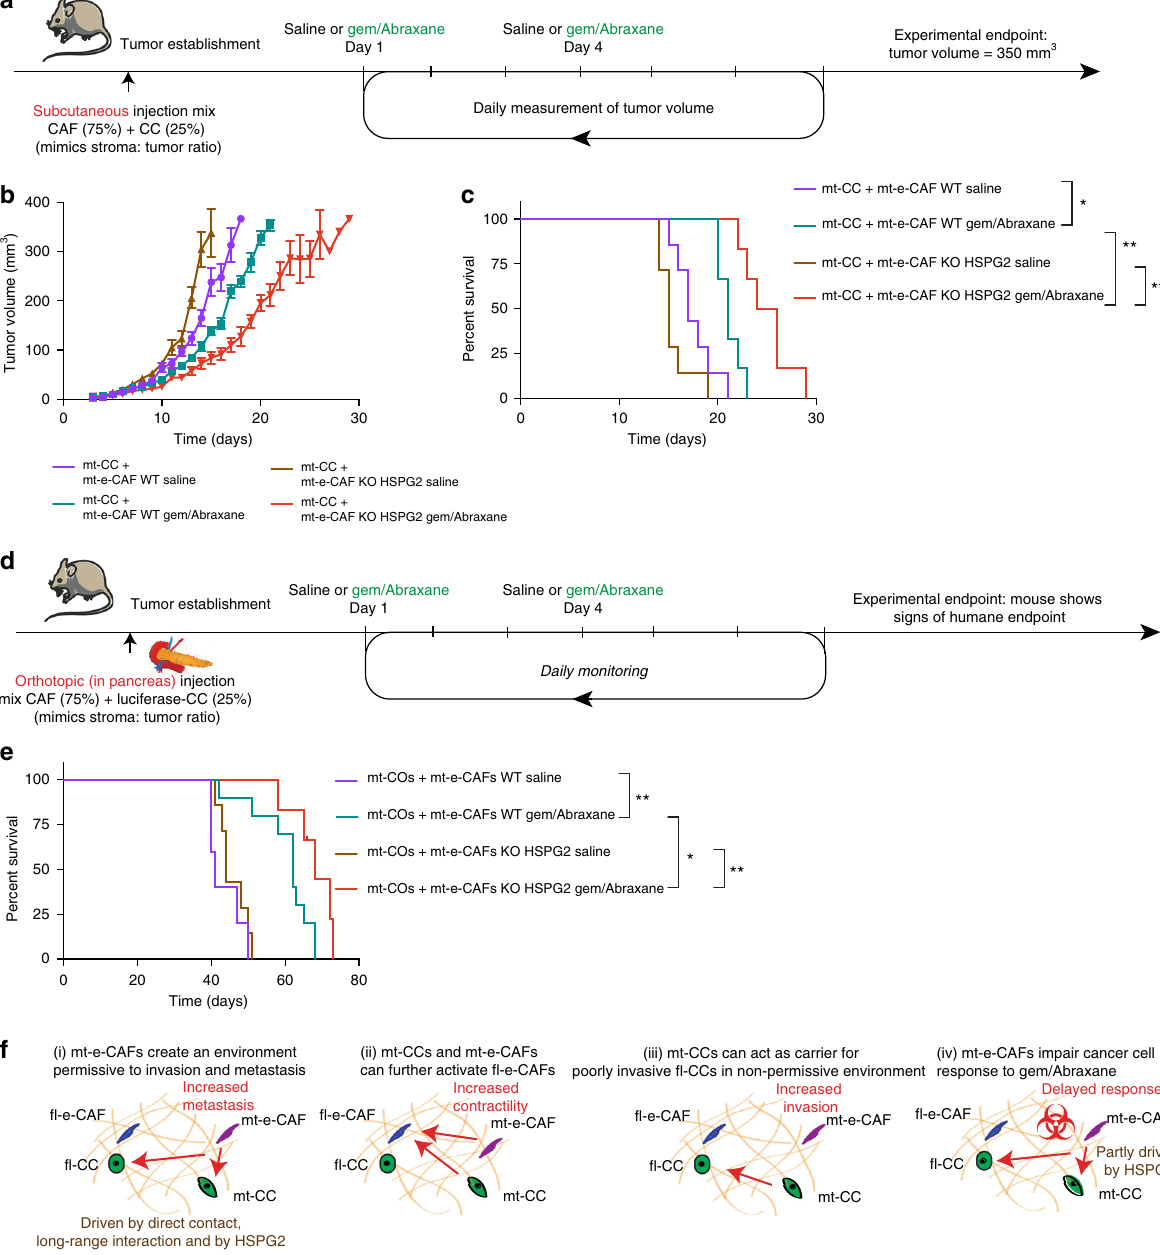
For assessment of Ki67 and cleaved-caspase 3 (CC3) staining, the ratio was the 12-day invasion phase. After invasion, organotypic matrices were imaged or fi xed in 10% formalin and processed for histochemistry analyses. Invasive index normalized to the value for mt-CCs treated with control. For each experiment, cells were counted in three fi elds of view per matrix, with three matrices per repeats and was measured in three representative areas per matrix and as per the formula: three biological replicates in total. Numberof invadingcells ´ 100 Invasiveindex ¼ Numberof invadingcells þ numberof non (cid:2) invadingcells ð Þ Imaging and quanti fi cation of collagen birefringence . Paraf fi n-embedded samples were cut into 4 µm sections and stained with 0.1% picrosirius red (Poly- Clusters of cells invading together were de fi ned as more than four cancer cells in sciences) for fi brillar collagen according to manufacturer ’ s instructions. Polarized close proximity and invading together into the CAF-collagen matrix.